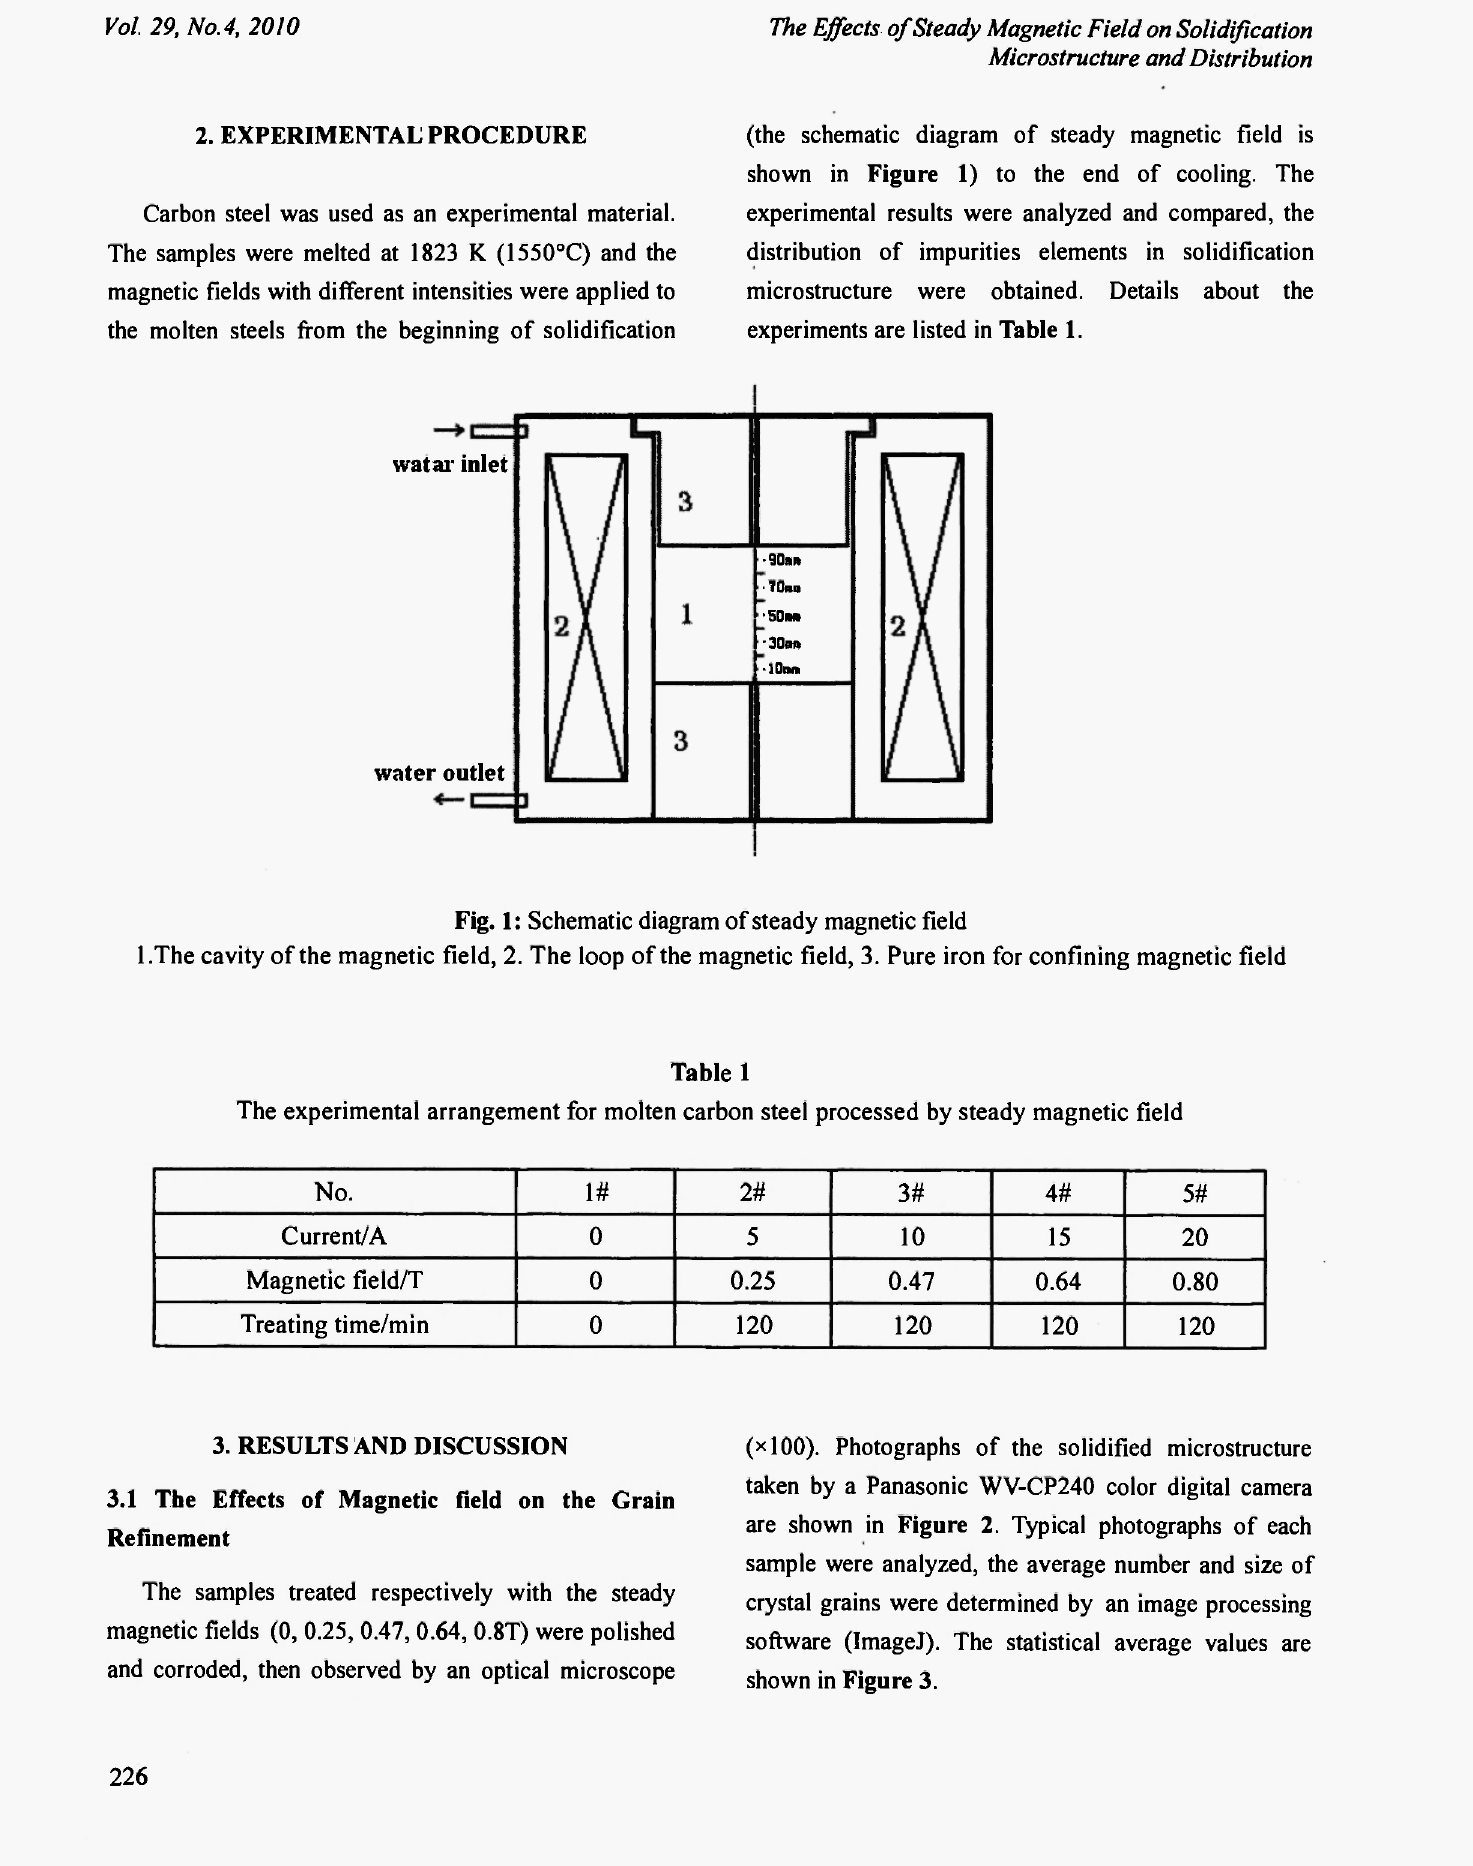
shown in Figure